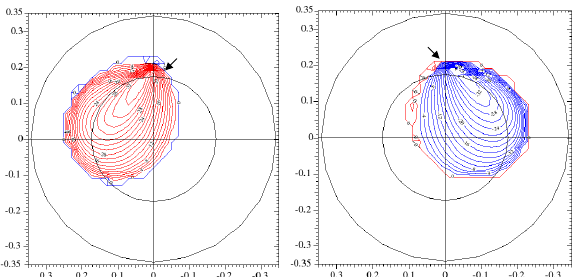
Figure 10. Case 2. Left: Northern polar cap convection lines. Only a single clockwise lobe cell shows up because the second minor counterclockwise lobe is very small for this event IMF direction. The arrow marks the ionospheric projection of the cusp. Right : Southern polar cap convection lines are shown. Only a single clockwise lobe cell shows up because the second minor counterclockwise lobe is very small for this event IMF direction. The arrow marks the ionospheric projection of the cusp.